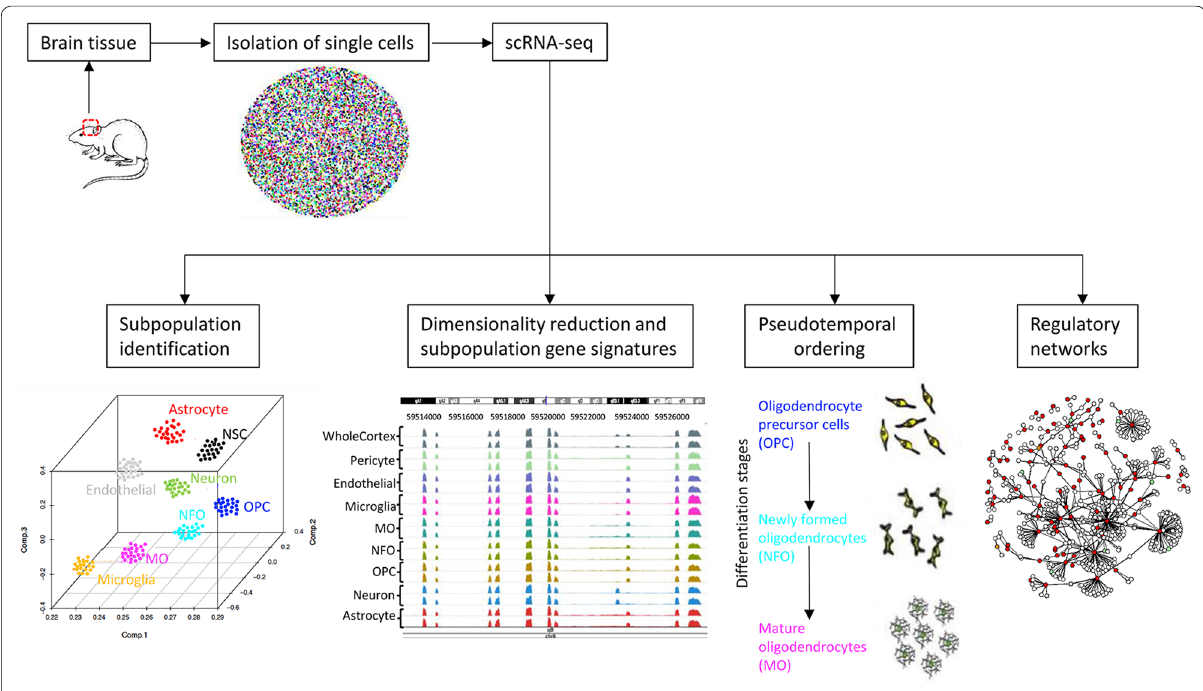
Fig. 5 Overview of scRNA‑seq downstream analyses